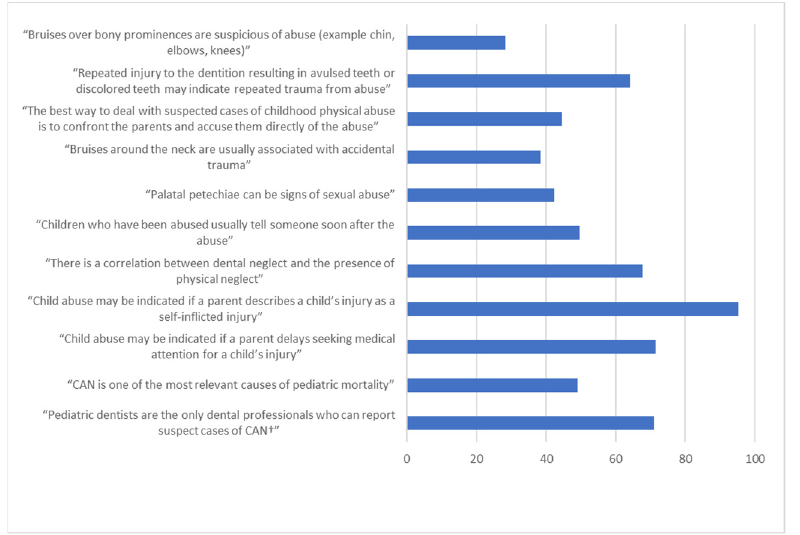
Figure 1. Percentages of the participants with correct answers to knowledge-based items in the questionnaire ( n = 988). † Child abuse and neglect. Table 2. Participants’ knowledge scores in association with key variables of the study sample ( n = 988).